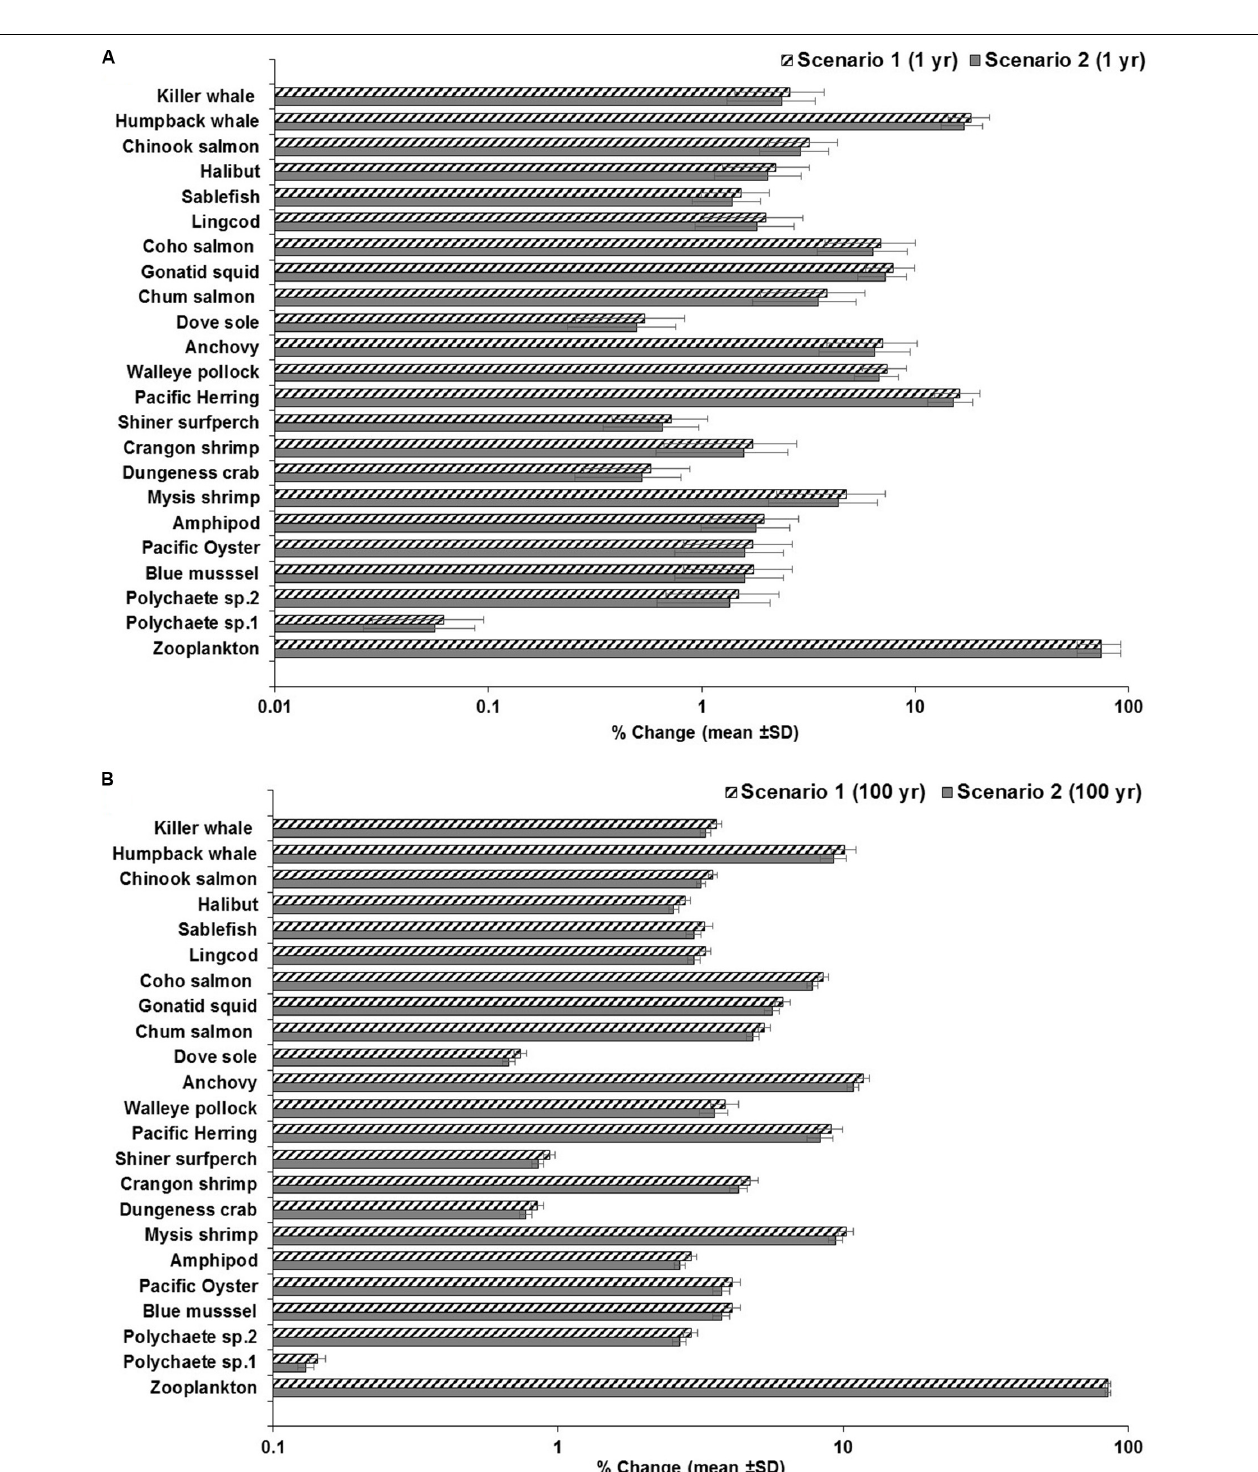
FIGURE 7 | Outcomes of the sensitivity analysis showing the response of the food web to changes in the elimination rate of zooplankton at 1 and 100 years. (A) scenario 1: from k E = 1/d to k E = 0.143/d with low concentrations in water and sediment (0.003 g/L and 0.266 g/kg dw, respectively) at 1 year, as a conservative scenario; scenario 2: from k E = 1/d to k E = 0.143/d with moderate concentrations in water and sediment (0.010 g/L and 0.886 g/kg dw) at 1 year, as a least conservative scenario (scenario 1); and (B) scenario 1: from k E = 1/d - to k E = 0.143/d at low concentrations in water and sediment (same as above) at 100 years, as a conservative scenario; scenario 2: from k E = 1/d to k E = 0.143/d with moderate concentrations in water and sediment (same as above) at 100 years, as a least conservative scenario.